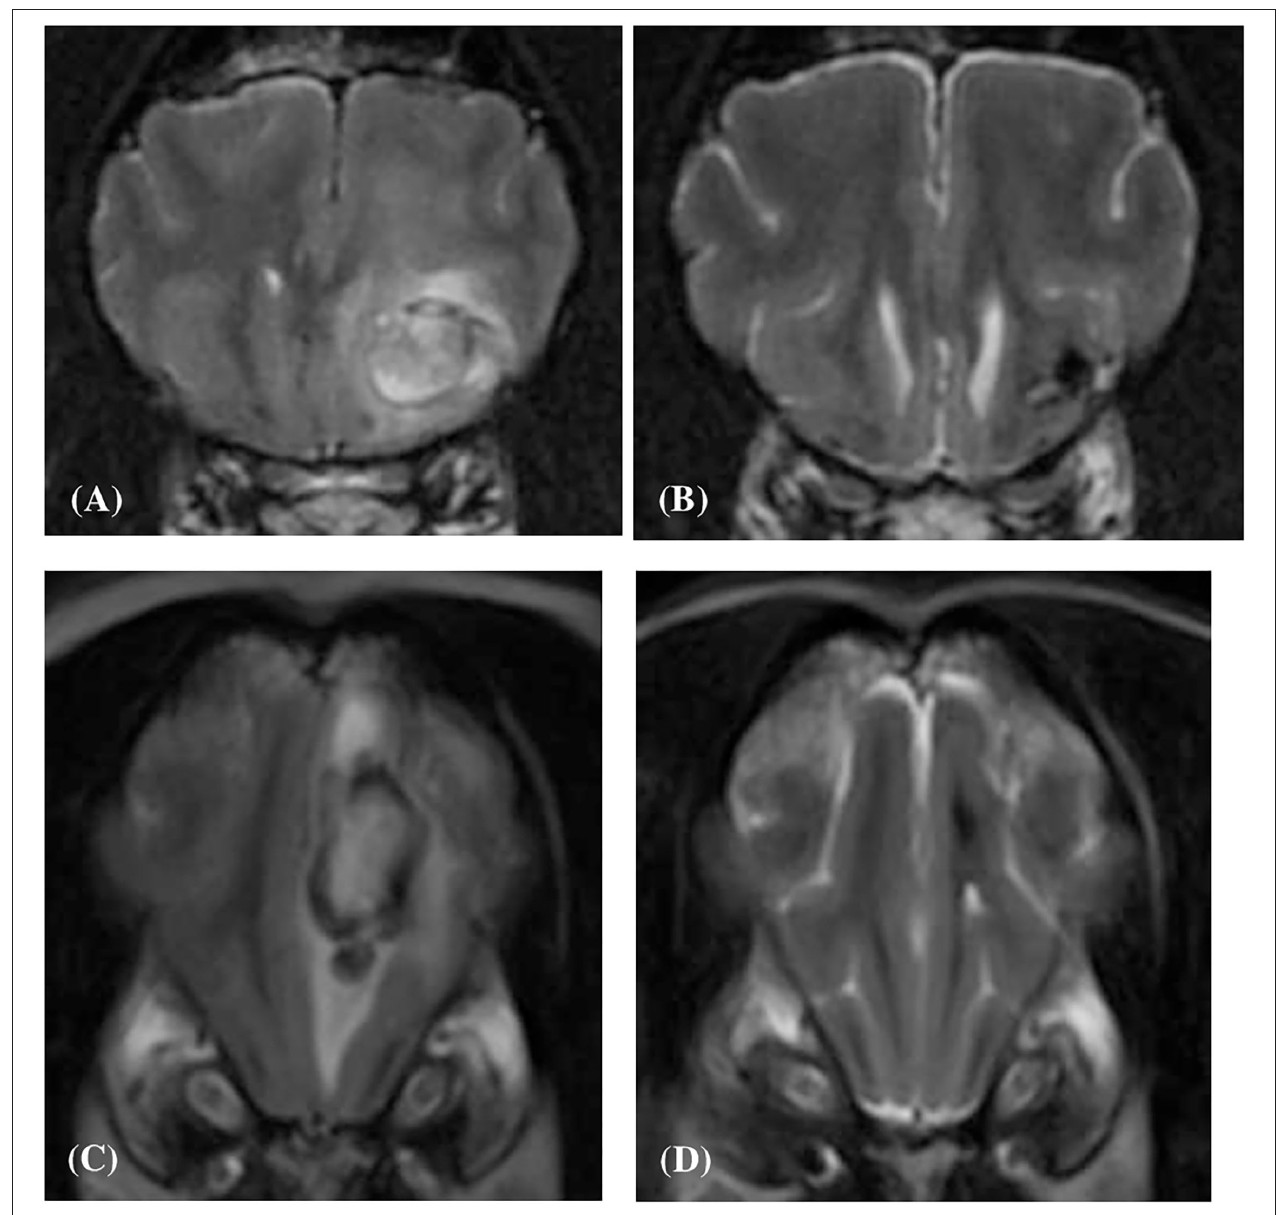
FIGURE 6 | Transverse T2-weighted image (A) of a dog (Case 10) with an intracranial intra-axial hematoma affecting white matter of the left frontal lobe at first presentation. Transverse T2-weighted image (B) of the same dog as displayed in (A) at the same location but 83 days later. Transverse T2-weighted image (C) of a dog (Case 2) with an intracranial intra-axial hematoma affecting the white matter of the left frontal lobe (centrum semiovale) at first presentation. Transverse T2-weighted image (D) of the same dog as displayed in (C) at the same location but 207 days later. In both the follow up images (B,D) the lesions have reduced dramatically in volume, are uniformly hypointense and perilesional oedema has resolved. This is illustrative of normal intra-axial intracranial hematoma contraction and maturation.